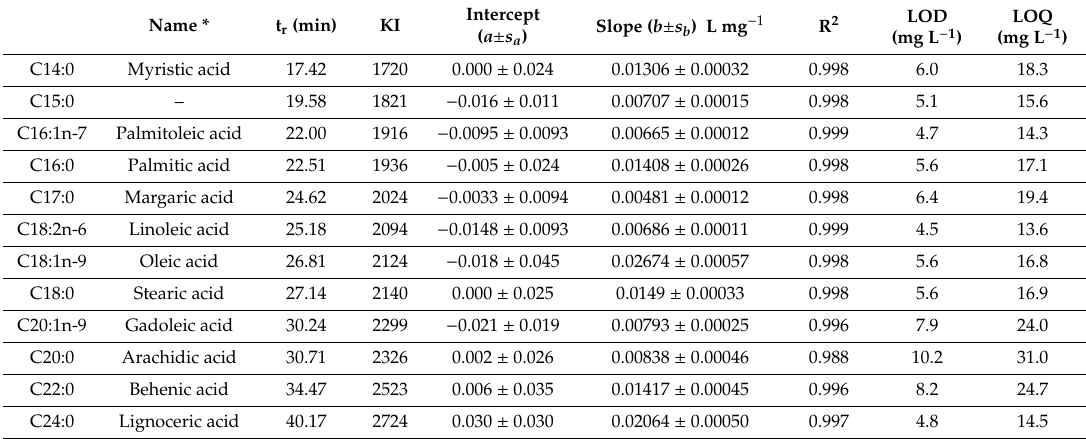
Table 1. Performance data of the optimized gas chromatography-mass spectrometry (GC-MS) separation and quantification method.